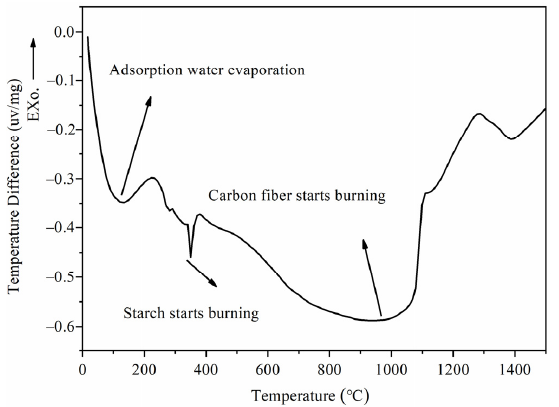
Figure 2. DTA curve for alumina with starch and carbon fibers.